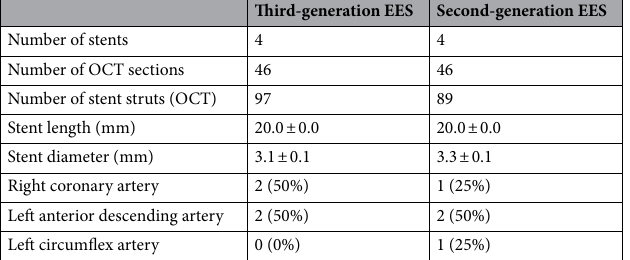
Table 2. Stent data of 4-week follow-up low-density lipoprotein receptor knockout